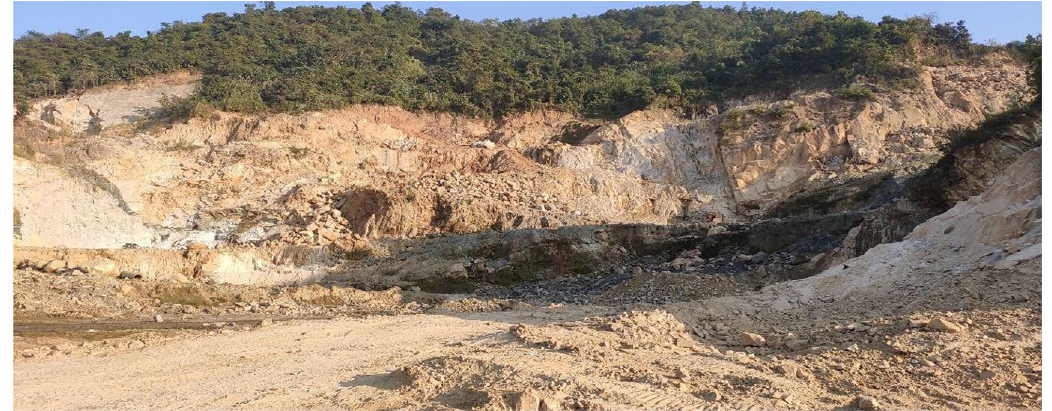
Fig. 8 Most sensitive soil erosion on the exposed surface near the Rani area of the lower Kulsi basin (image collected by the author from the field)